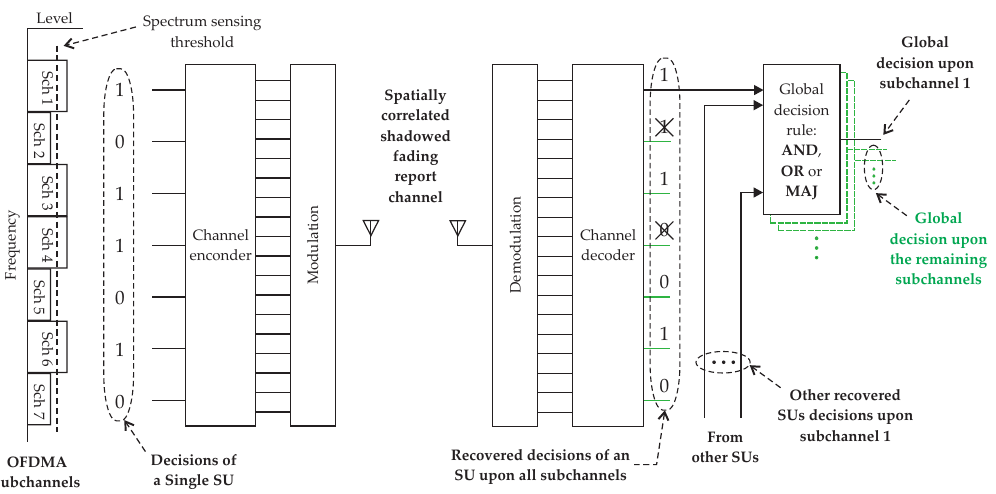
Figure 2. Didactic representation of the coded decision fusion process. The spectrum sensing and report is illustrated for a single